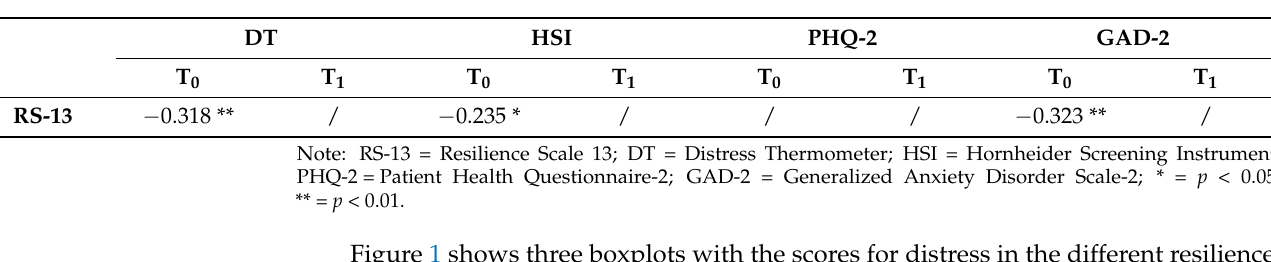
Figure 1. Distress in different resilience levels. Table 6. Correlations between resilience and distress, need for psychosocial support, depression, and